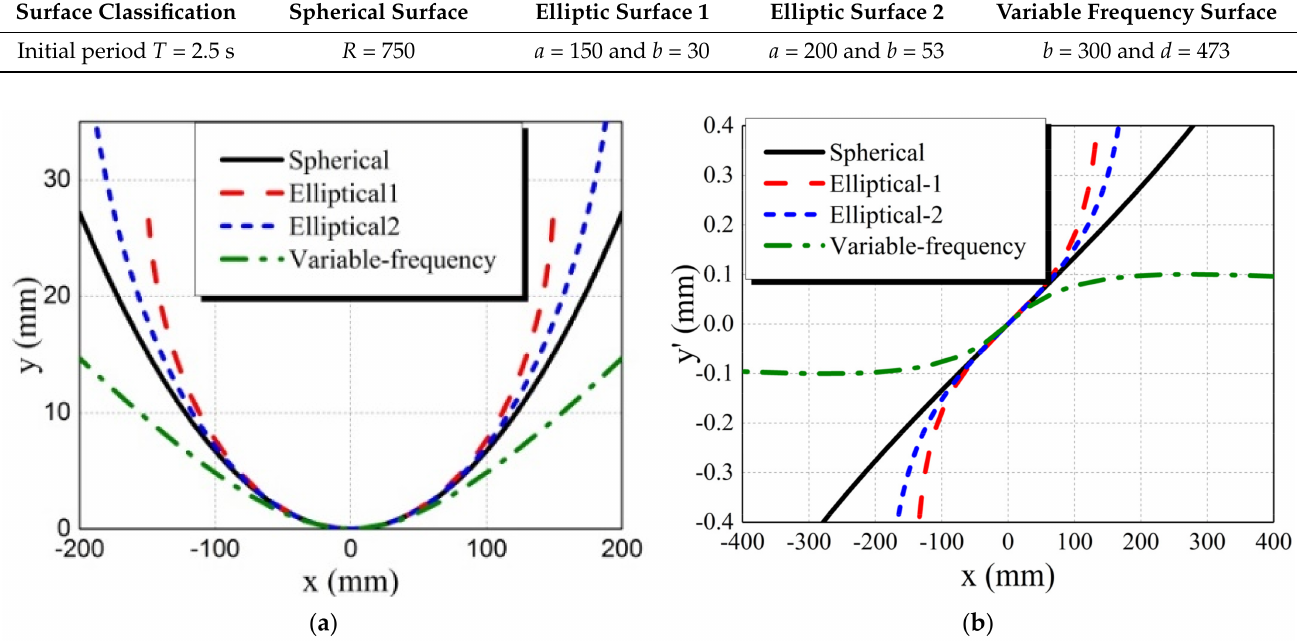
Figure 4. ( a ) The geometrical shape and ( b ) slope comparisons between the four